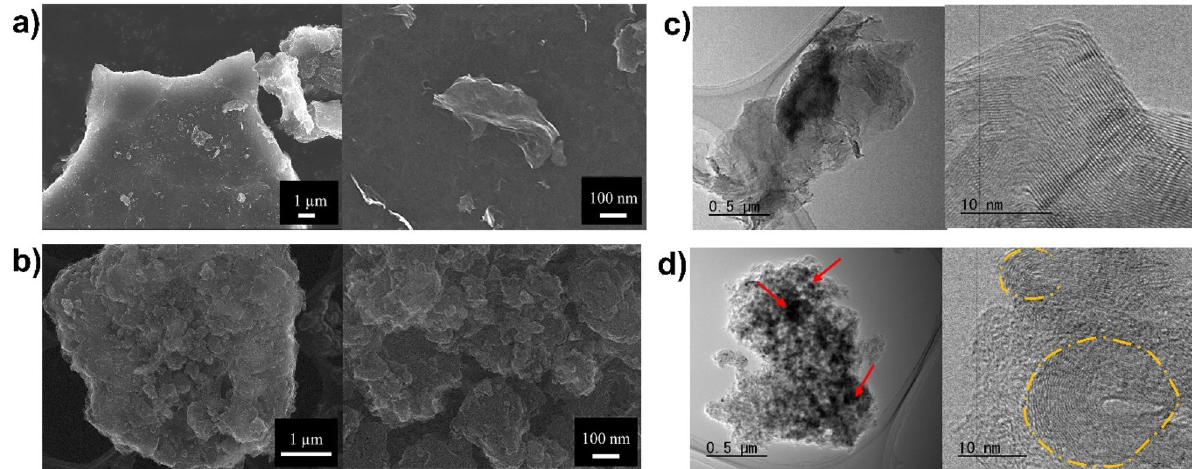
Figure 2. FE-SEM images of ( a ) PC at the magnitudes of × 5 k and × 100 k and ( b ) LC at the magnitudes of × 5 k and × 100 k, synthesized from TBB via SP at a frequency of 100 kHz for 60 min. TEM and high-resolution TEM images of ( c ) PC and ( d ) LC synthesized from TBB via SP at a frequency of 100 kHz for 60